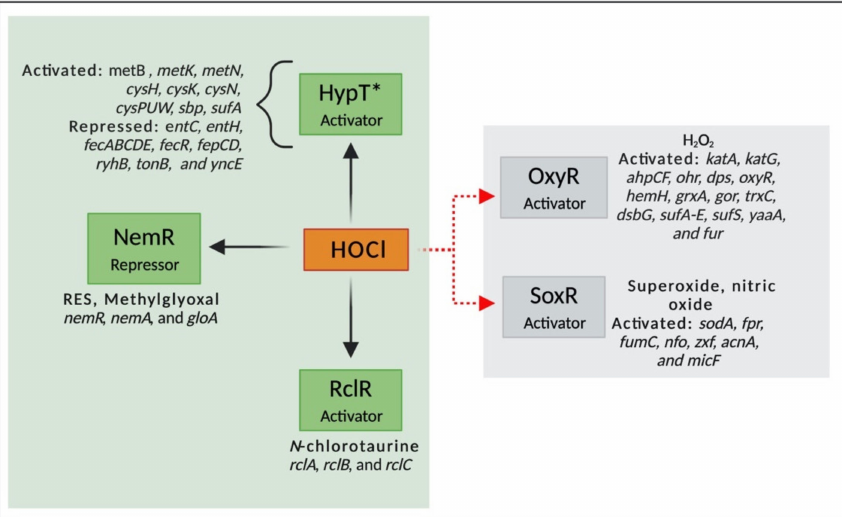
Figure 5. Activation of transcriptional factors by HOCl stress (green area). *HypT is the only regulator known to be specifically activated by HOCl. Its activation induces the expression of genes involved in cysteine, methionine, and sulfur biosynthesis, and downregulates genes involved in iron acquisition and homeostasis. NemR, a regulator responsive to HOCl, RES, and methylglyoxal, upregulates genes involved in glyoxylase and N -ethylmaleimide synthesis. RclR is activated by HOCl and N -chlorotaurine and expresses a flavoprotein disulfide reductase, an uncharacterized periplasmic protein, and transmembrane quinone-binding protein. The gray area shows the genes regulated by OxyR and SoxR, the most studied ROS-sensors. HOCl: hypochlorous acid; H 2 O 2 : hydrogen